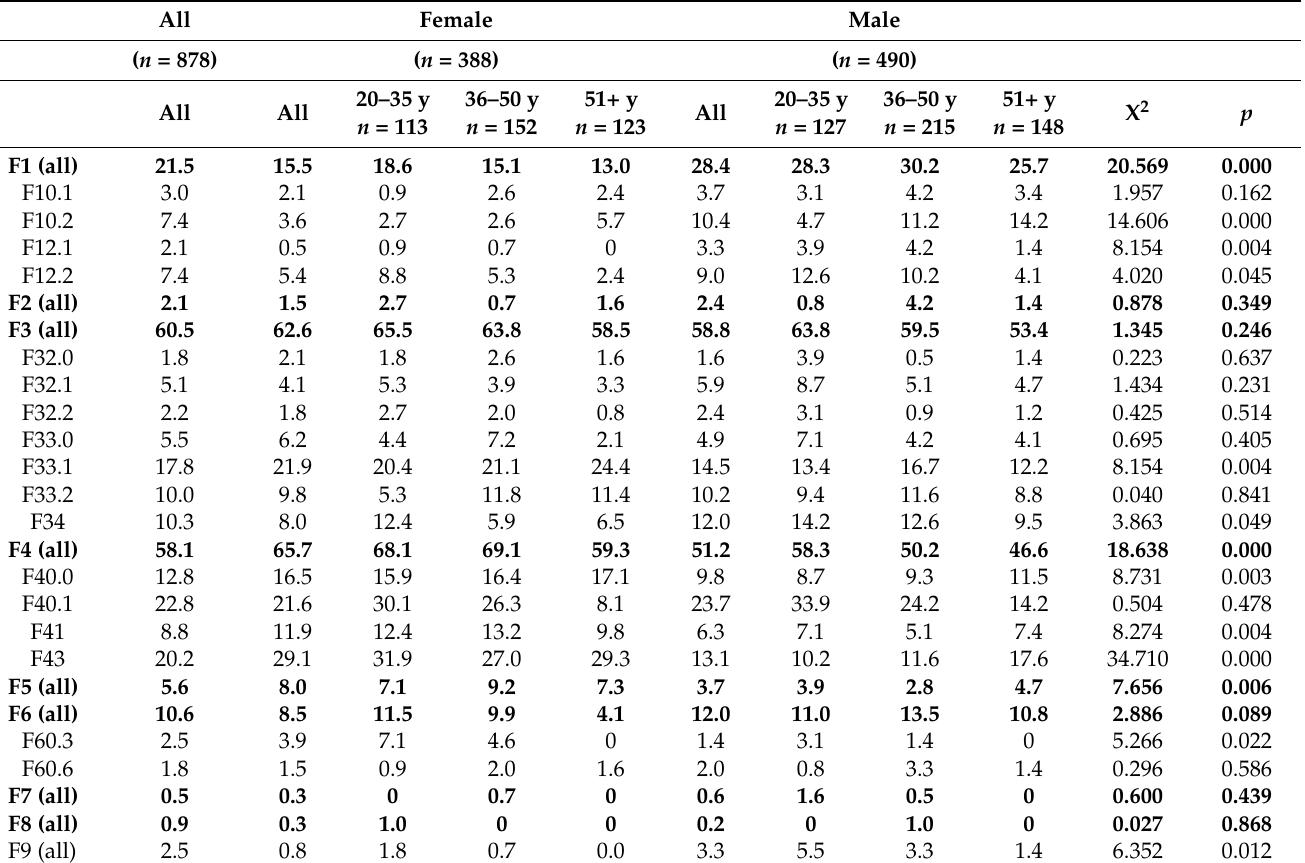
Table 2. Frequencies (%) of psychiatric diagnoses in sexes and age groups (in years) subdivided in ICD-categories and most frequently diagnosed disorders of the respective